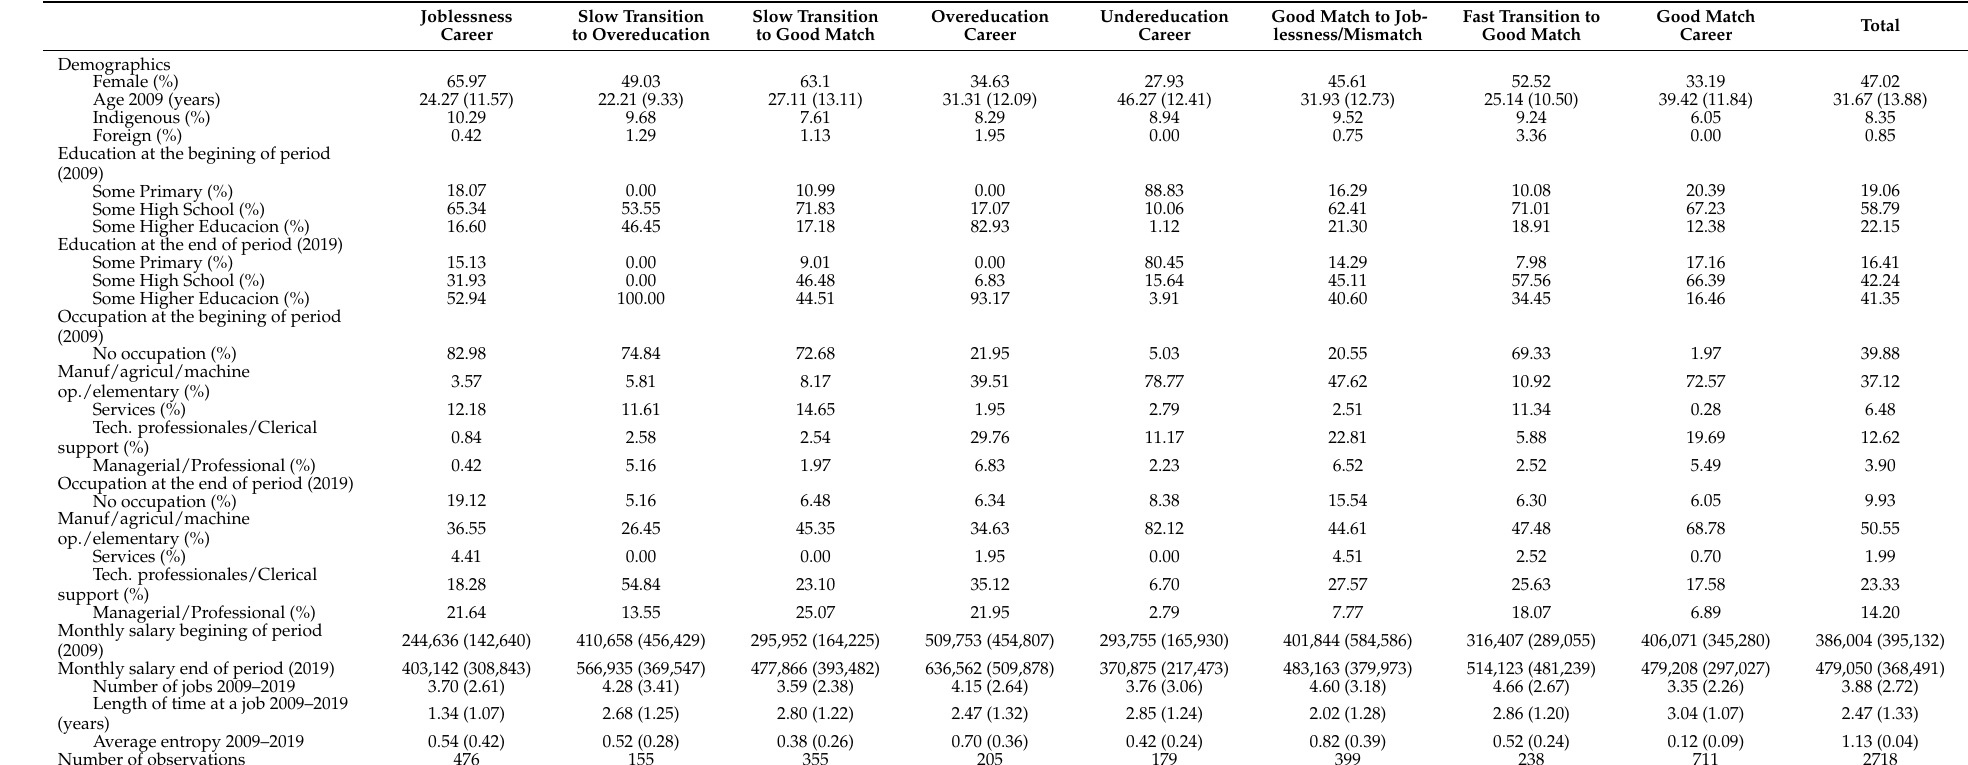
Table A3. Descriptive statistics of the sample and by educational mismatch